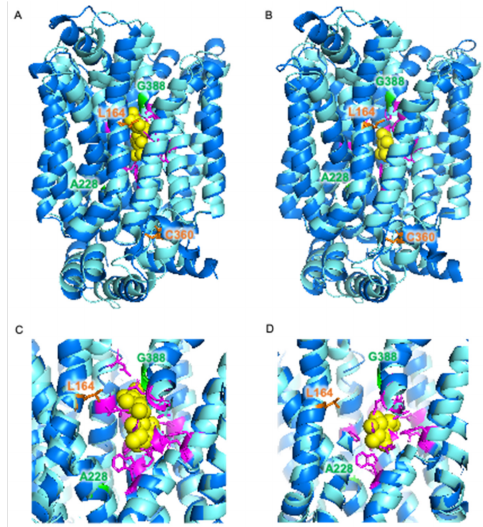
Figure 4. Superimposition of homology model of S. cerevisiae Mal11 (turquoise) [41] and crystal structures of human GLUT3 (blue) [42] bound to maltose (PDB: 4ZWB) ( A , C ) and bound to glucose (PDB: 4ZW9) ( B , D ). Glucose and maltose are represented by yellow spheres. Amino acid residues involved in sugar binding in GLUT3 are shown in magenta, and amino acid residues in Mal11 that were substituted during evolution of IMZ786 are shown in orange and